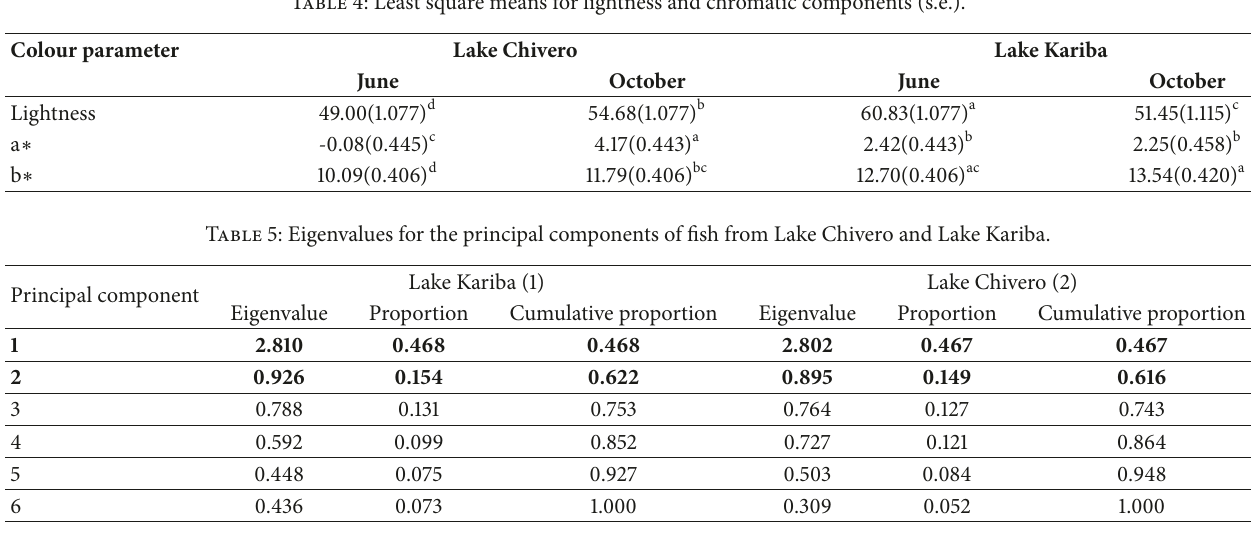
Table 4: Least square means for lightness and chromatic components (s.e.).